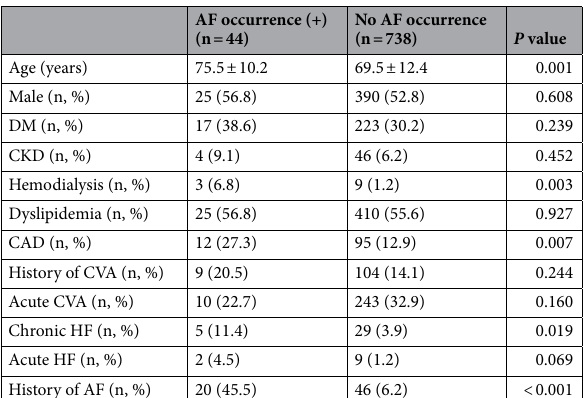
Table 2. Clinical characteristics according to the occurrence of atrial fibrillation in patients with hypertension. AF, atrial fibrillation; DM, diabetes mellitus; CKD, chronic kidney disease; CAD, coronary artery disease; CVA, cerebrovascular accident; HF, heart failure.